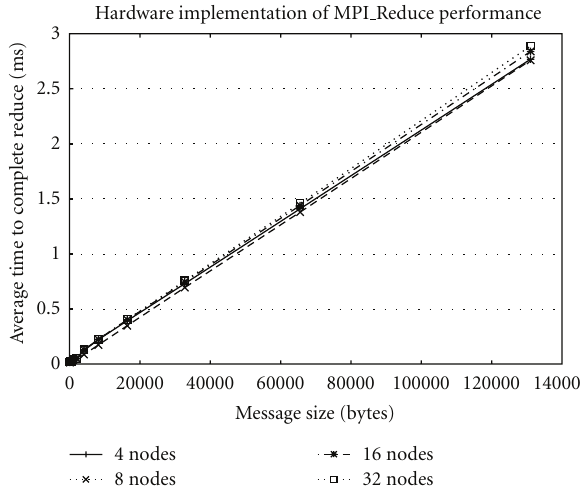
Figure 11: Measured MPI Reduce performance of di ff erent net- work topologies on